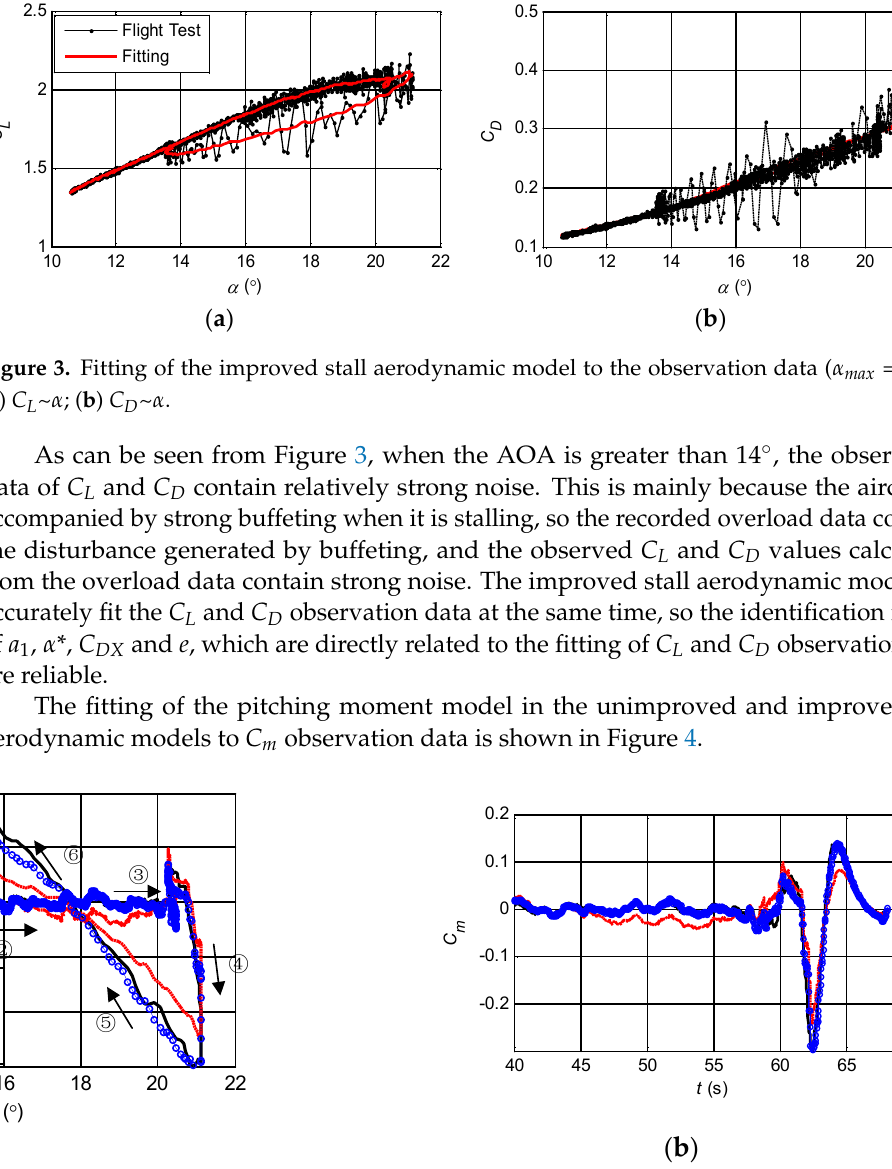
Figure 4. Fitting of unimproved/improved stall aerodynamic model to the pitching moment observation data. ( a ) C m − α ; ( b ) C m − t .